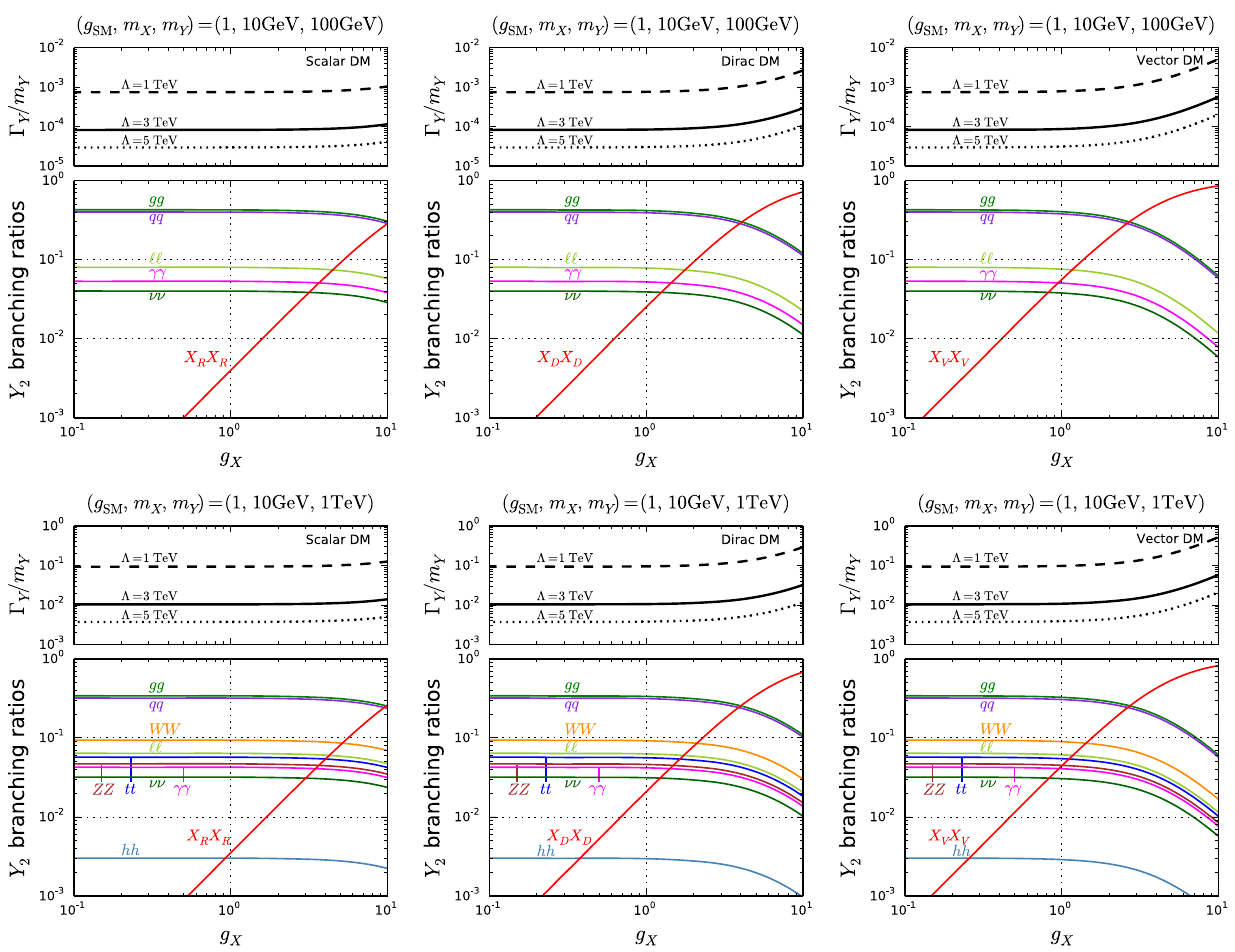
Fig. 2 Ratio of the mediator total width to its mass and mediator branching ratios as a function of the DM coupling g X , for mediator masses of 100 GeV ( top row ) and 1 TeV ( bottom row ). The left , middle